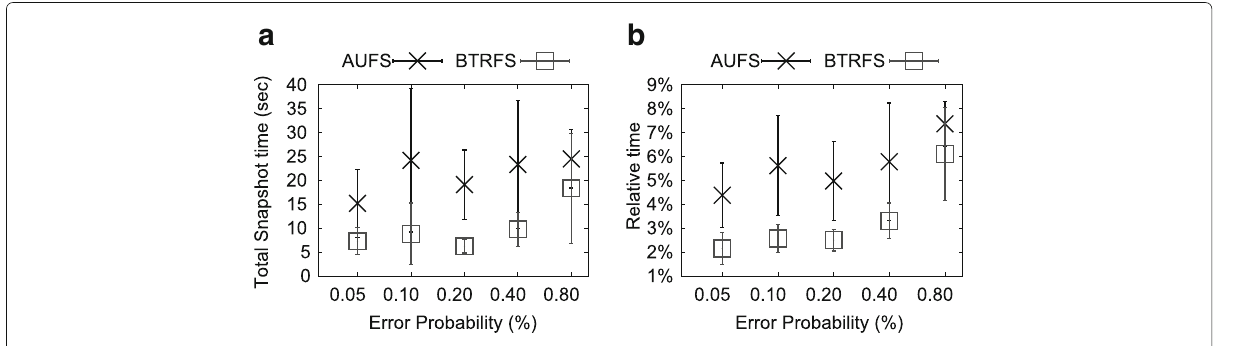
Fig. 11 Overhead of AUFS and BTRFS for Hadoop. a Total Snapshot Time. b Relative Time